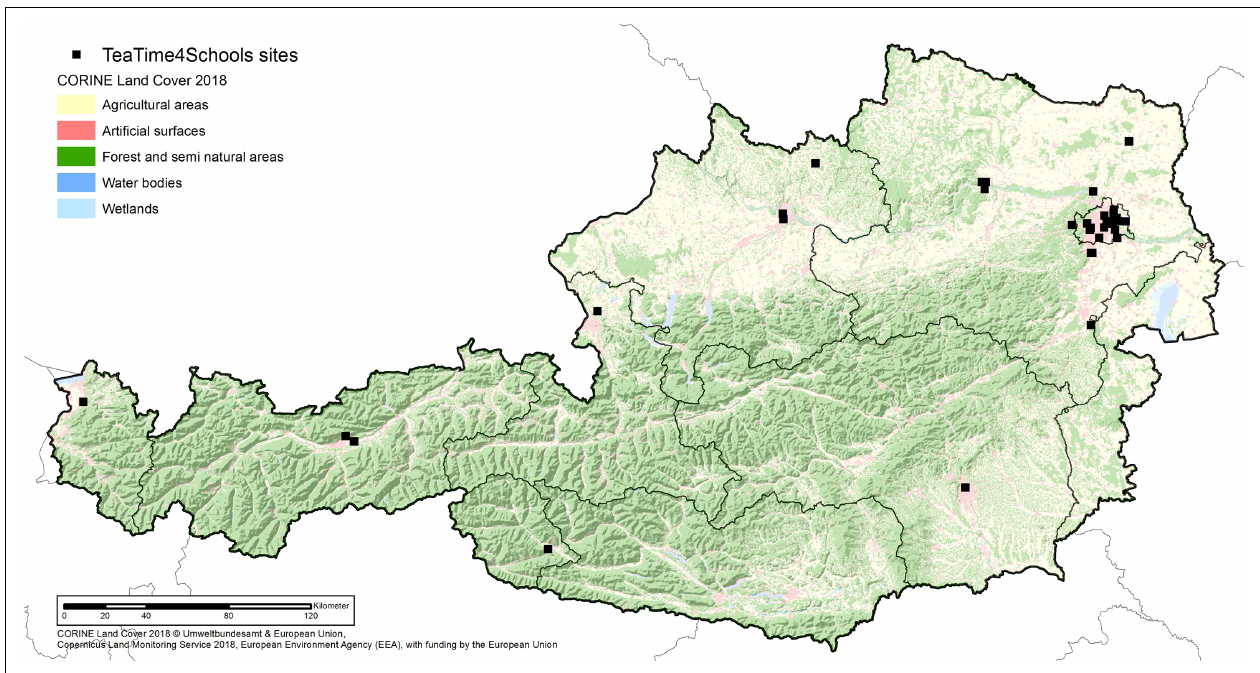
FIGURE 1 | Distribution of urban sites investigated across